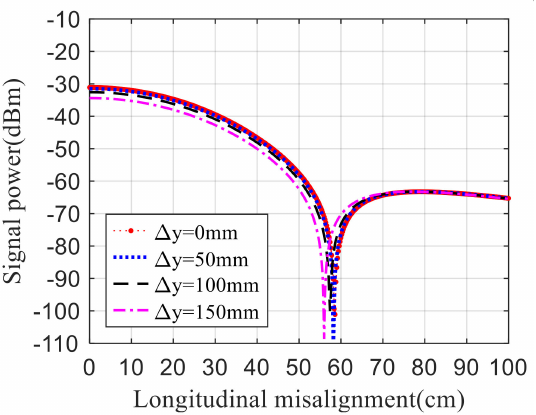
Figure 19. Variation of uplink received signal power at different lateral deviation between the OAU and the balise.